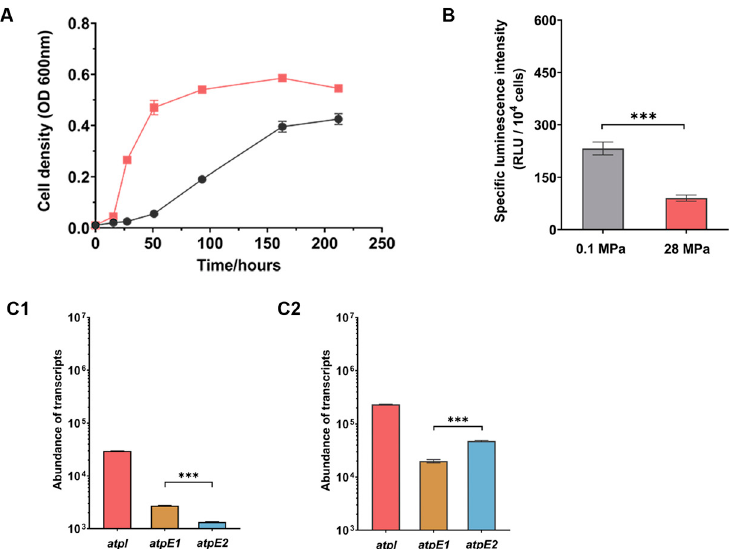
Figure 4. Growth curves, ATP level and expression of ATPase genes in SS9R wild-type strain cultured in MG medium. Panel ( A ), growth curve of SS9R at 0.1 MPa and 28 MPa. The black lines represent growth at 0.1 MPa and the red lines represent growth at 28 MPa. Panel ( B ), intracellular ATP level in S99R cells at exponential phase at 0.1 MPa and 28 MPa; the values show luminescence intensity per 10 4 cells. Panel ( C1 , C2 ), abundance of atpI , atpE 1 and atpE 2 transcripts at 0.1 MPa ( C1 ) and 28 MPa ( C2 ), respectively. The statistical analysis of comparisons between two groups was performed using an unpaired-sample t-test: ***, p < 0.001.